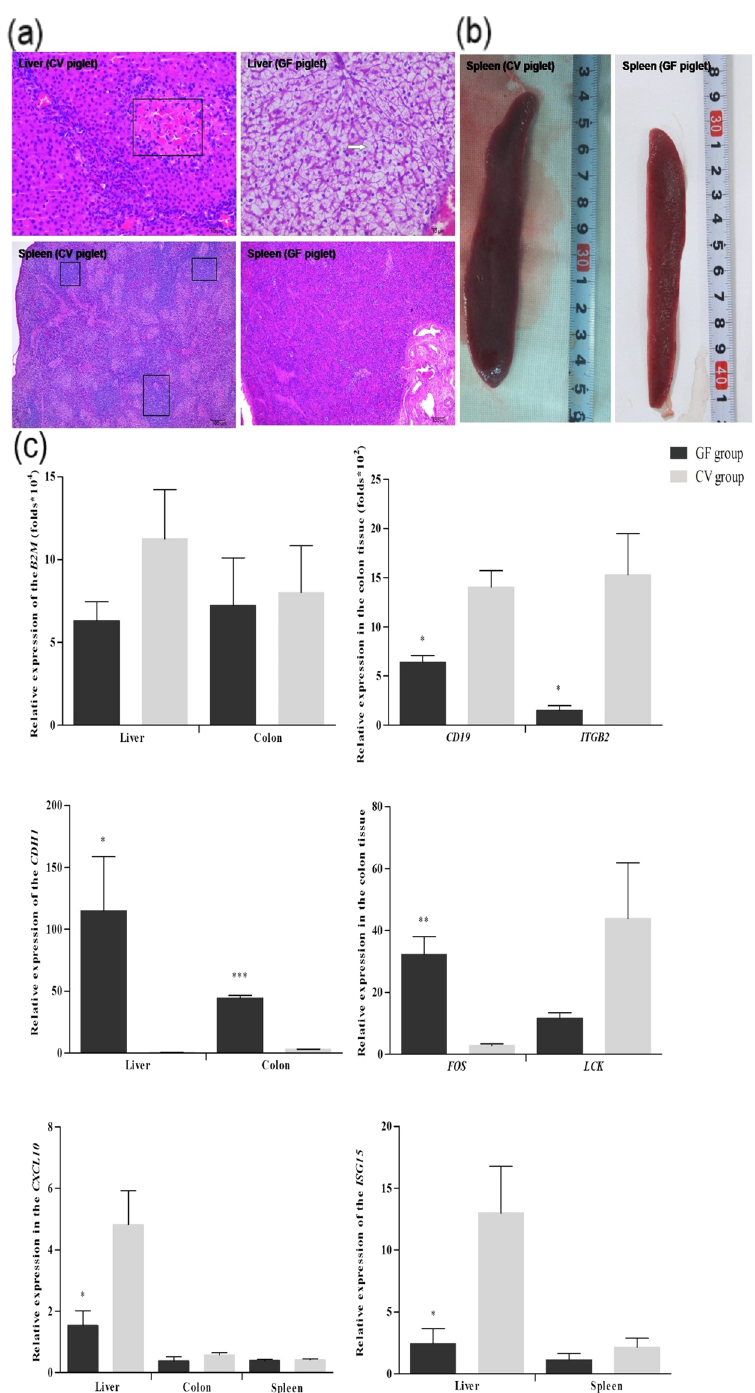
Figure 3. Morphological changes caused by the absence of a microbiota. ( a ) The hematoxylin-eosin (HE) staining results. ( b ) Spleens of germ-free (GF) and cesarean-derived conventional (CV) piglets. ( c ) Validation of DEGs with quantitative real-time PCR (QPCR). In the QPCRs, relative gene expression levels were calculated using the ΔΔ Ct method and normalized against the reference gene ß-actin. The Y-axis represents fold change. We used unpaired Student’s t tests to evaluate the statistical significance of differences between the CV and GF piglets. * P < 0.05; ** P < 0.01; *** P < 0.001. All data are presented as means ± standard error